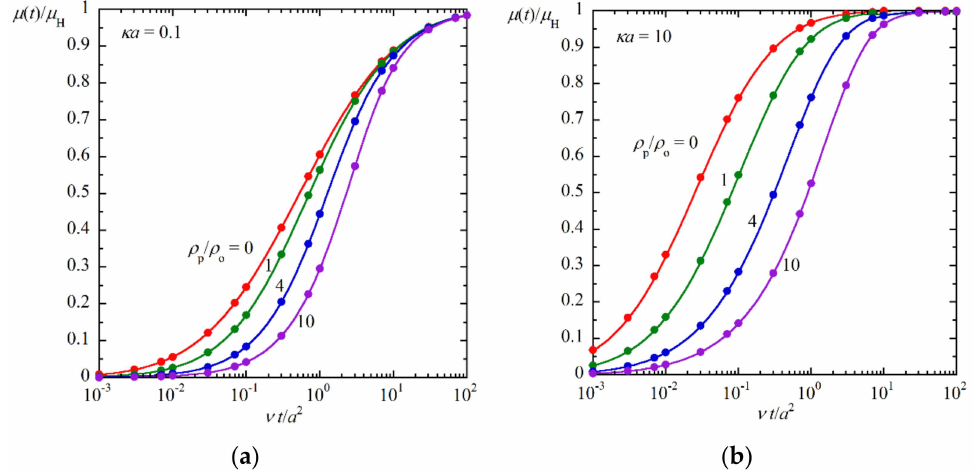
Figure 2. Time-dependent transient electrophoretic mobility µ ( t ) of a spherical colloidal particle of radius a and mass density ρ p in an electrolyte solution of the Debye length 1/ κ , mass density ρ o , and viscosity η . The ratio of µ ( t ) at time t to its value µ ( ∞ ) at t = ∞ , which is equal to Henry’s static mobility formula µ H (( µ ( ∞ ) = µ H ), is plotted as a function of the scaled time ν t / a 2 , ν being the kinematic viscosity (( ν = η / ρ o ). Solid lines are approximate results calculated with Equation (56) for ρ p / ρ o = 0, 1, 4, and 10 at κ a = 0.1 ( a ) and κ a = 10 ( b ). The symbols ( • ) are the corresponding exact numerical results by Huang and Keh [7]. The present approximation (Equation (56)) is found to be in excellent agreement with the exact numerical results